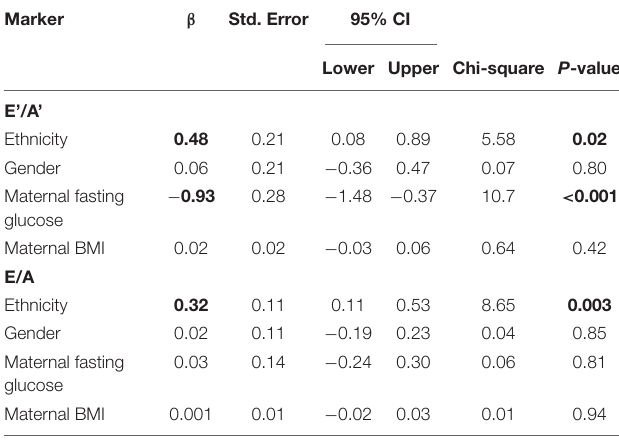
TABLE 5 | Generalized Linear Modeling with Child’s E (cid:48) /A (cid:48) or E/A as dependent variables and ethnicity (reference group SA), gender (reference group Male), maternal fasting glucose, and maternal BMI as